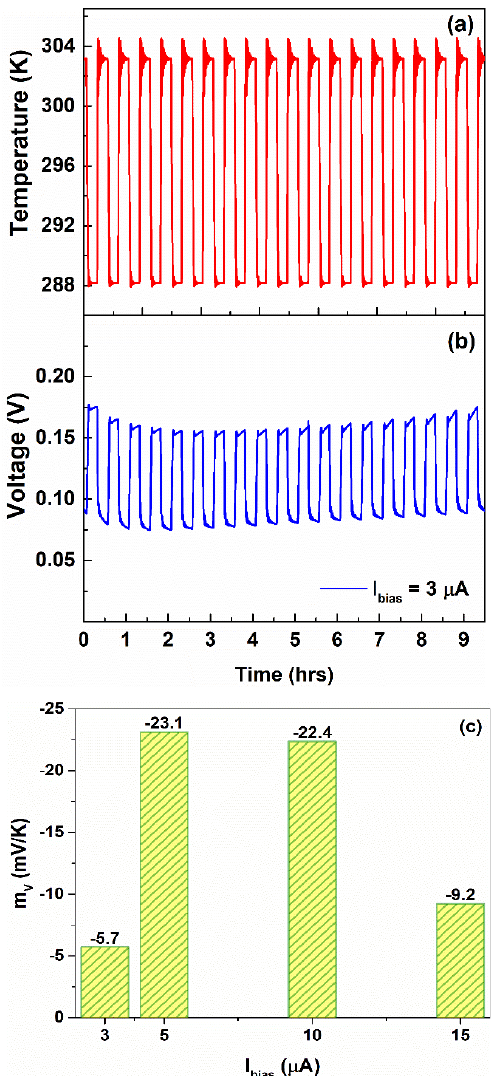
Figure 5. Time evolutions of the ( a ) square wave temperature profile imposed on the sample between 288 and 303 K during the cycling endurance test and ( b ) corresponding voltage signal measured at a bias current value of 3 μ A, respectively. ( c ) Voltage temperature sensitivity of the device for different bias currents.